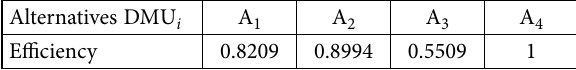
Table 6. DMU i efficiency units